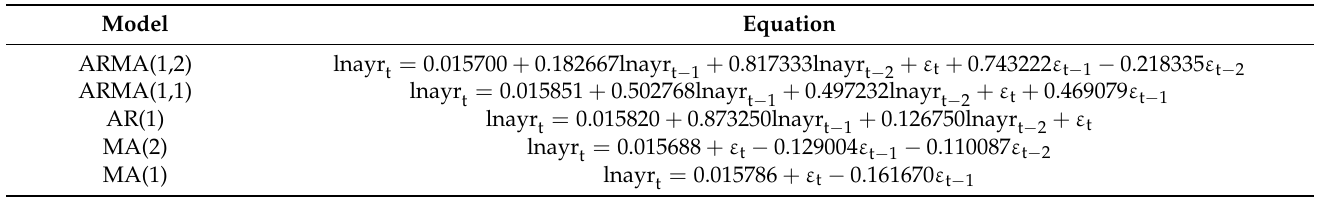
Table 3. Equations of five basic models for fitting average yields of world rice from 1961 to 2019. Model